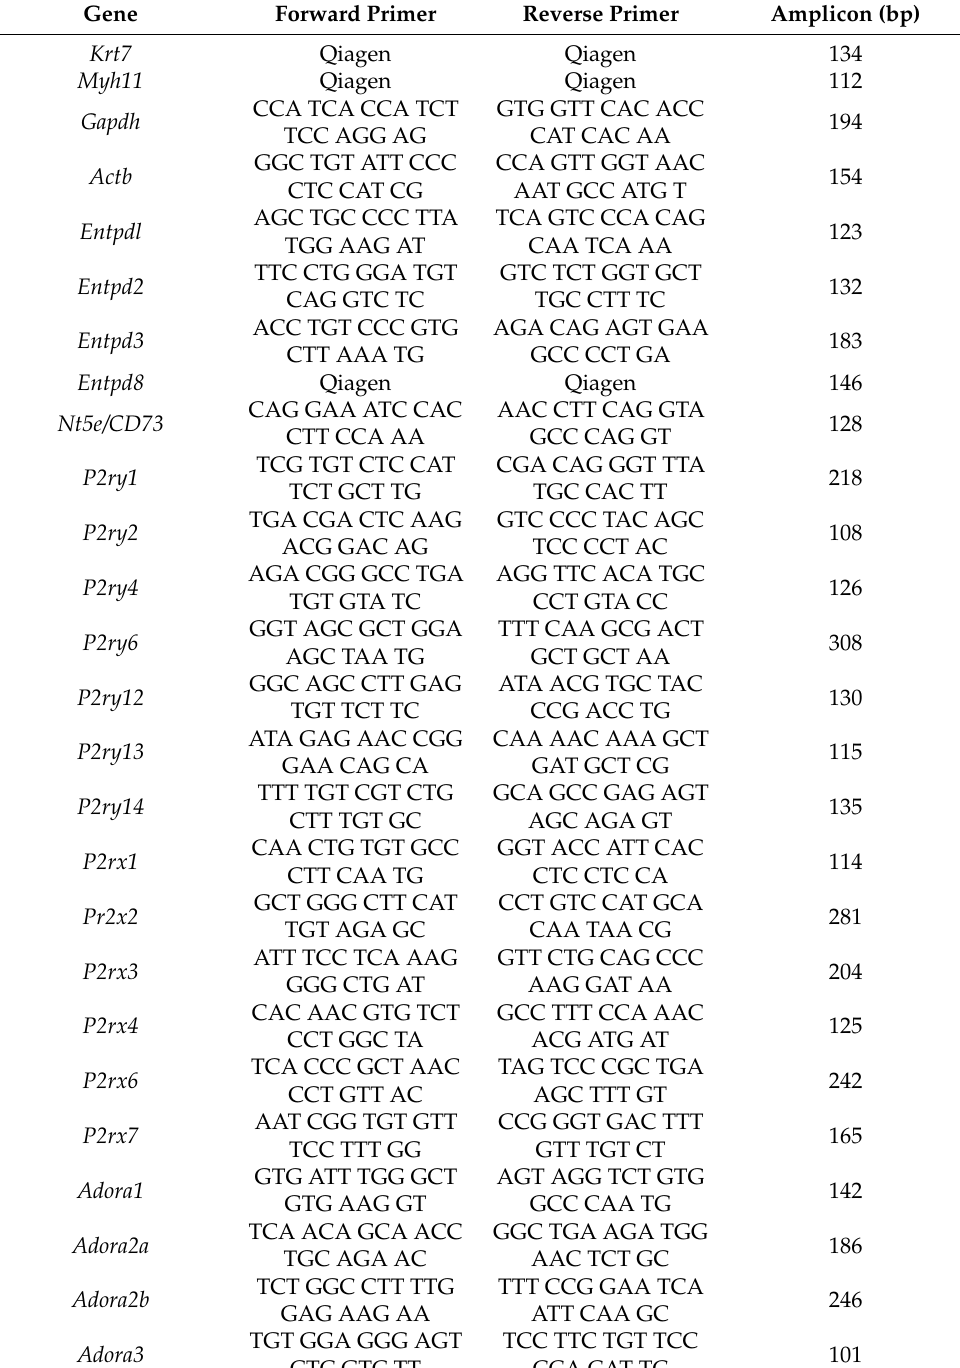
Table 1. qRT-PCR